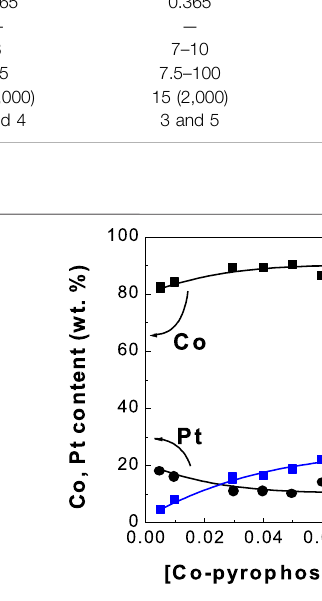
FIGURE 1 | Dependence of Co, Pt contents and current ef fi ciency (CE) of CoPt thin fi lm on Co-pyrophosphate